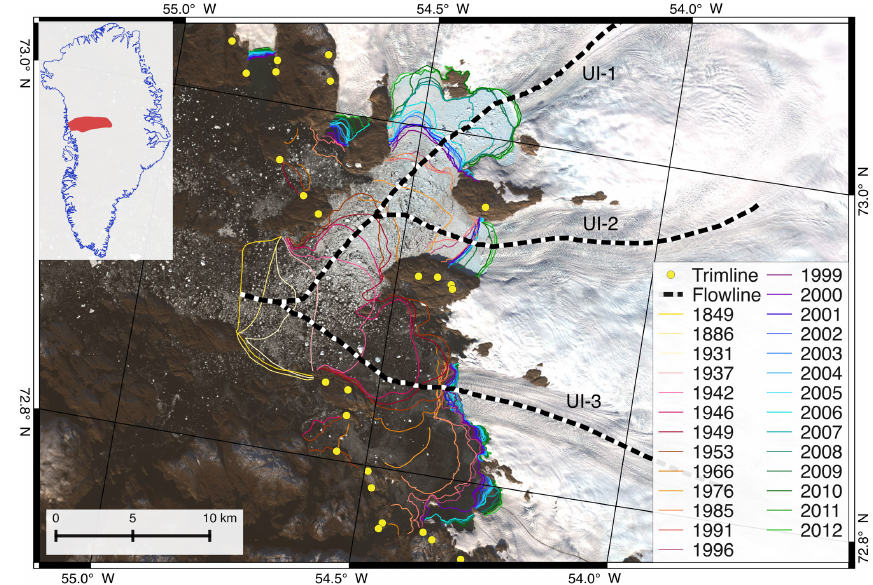
Figure 1. Upernavik Isstrøm’s observed margin front positions between 1849 and 2012 (lines) and trimline positions (yellow dots; Kjeldsen et al., 2015). The background image is from Landsat8 (September 2013). Inset is the location and shape of the Upernavik catchment (red area), determined by 2008/09 surface velocity from Rignot and Mouginot (2012), which define the model domain. Table 1. Data for initialising and evaluating the